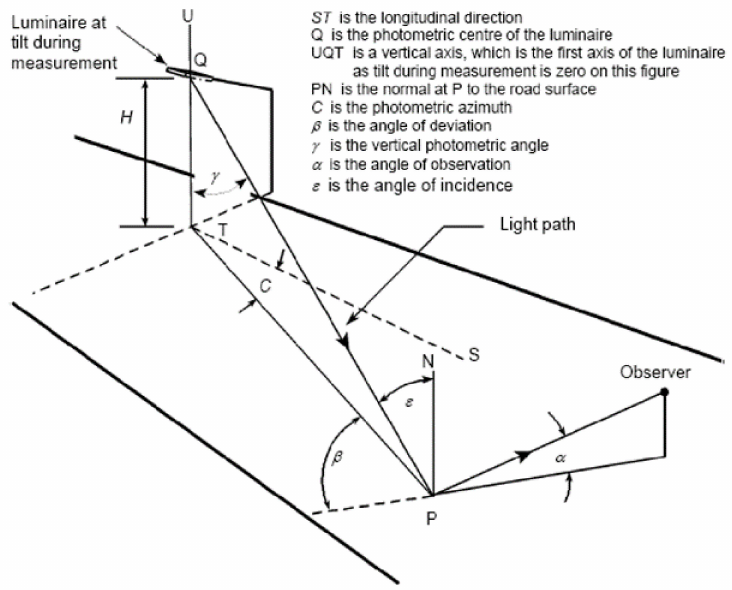
Figure 1. The relative relationship between the angle of observation and the road surface